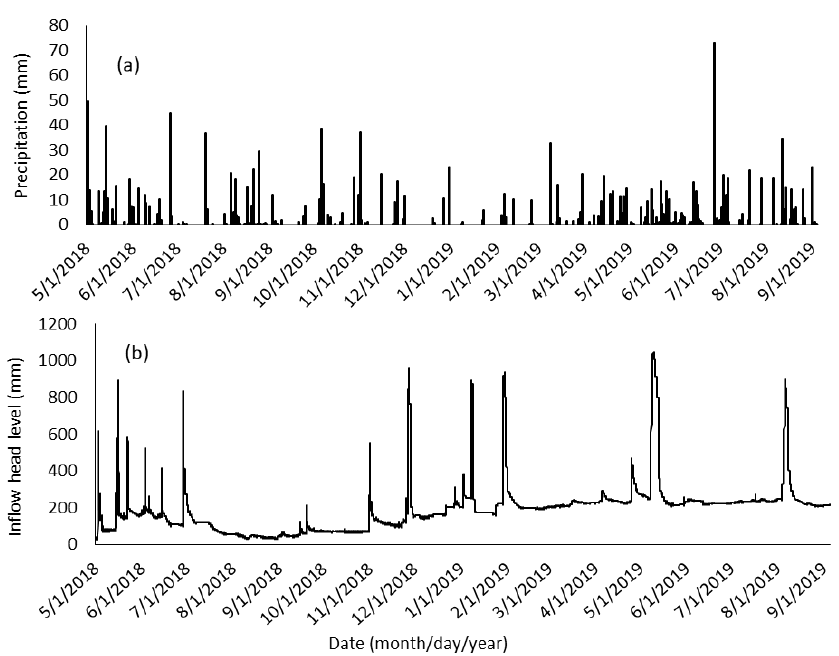
Figure 3. Daily precipitation record at the site of the subsurface tile drain P removal structure ( a ) and inflow pressure head level ( b ) measured at the inflow distribution manifold, illustrated in Figure 1.